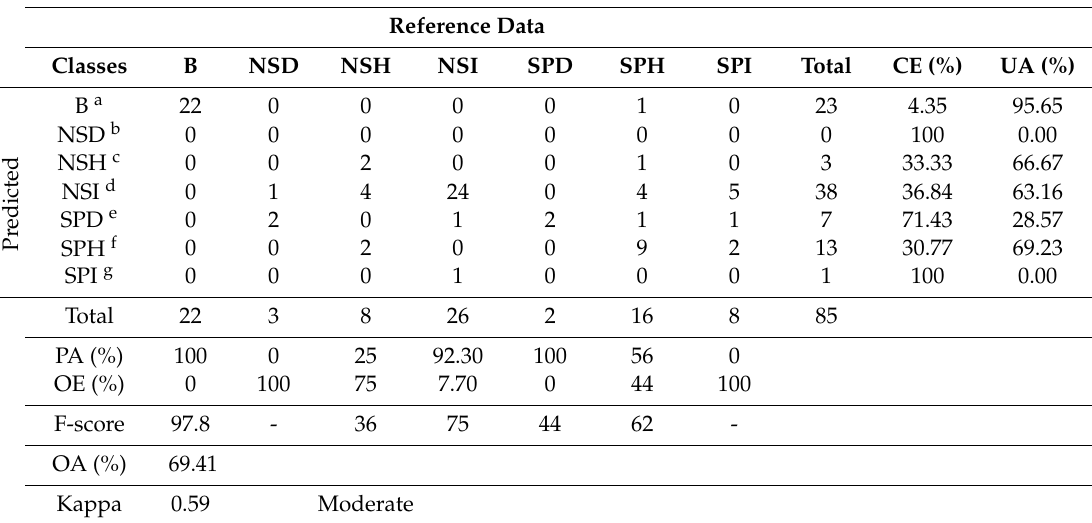
Table 8. Classification summary table and confusion matrix including combined tree species and health status derived from the support vector machine (SVM) analysis using a combination of VI and TA